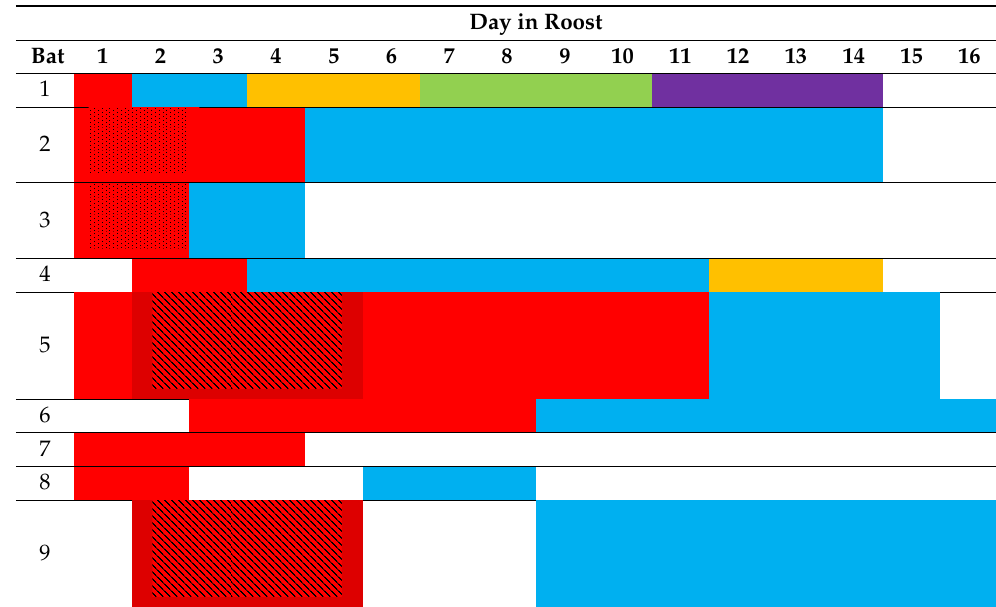
7 of 14 Table 1. The time of contact with individual bats and the time spent in their roosts. 1 – 9: individual bats with transmitters. 1 – 16: consecutive days, each cell stands for one day. The same colour indi- cates days spent in one roost. Example: bat number 1 inhabited five roosts consecutively, while